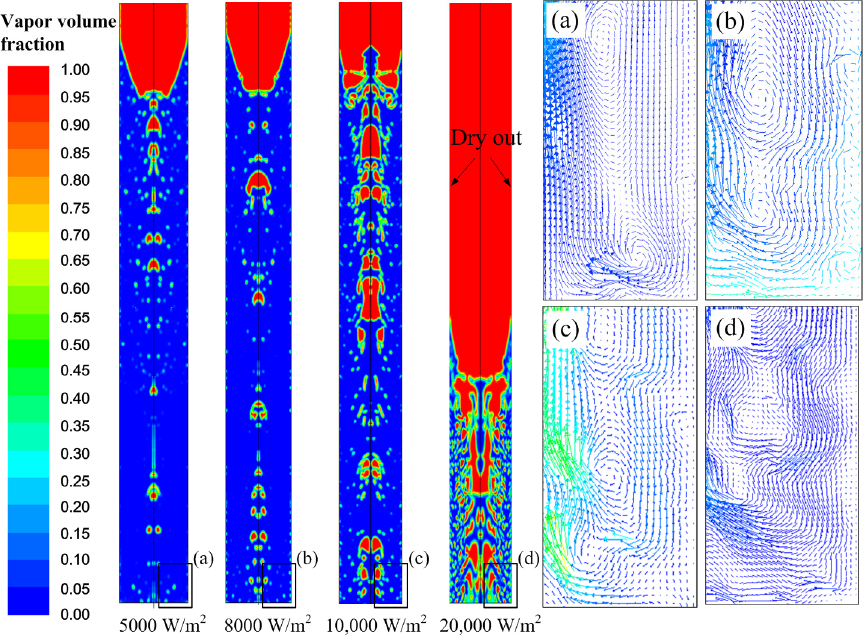
Figure 11. Heat transfer in the evaporator under different input heat flux. ( a ) 5000 W/m 2 ; ( b ) 8000 W/m 2 ; ( c ) 10,000 W/m 2 ; ( d ) 12,000 W/m 2 .